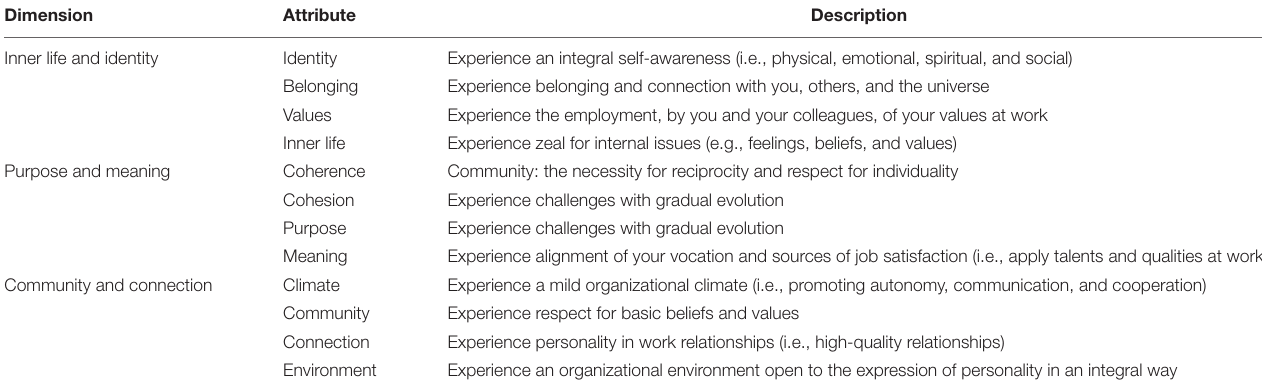
TABLE 1 | Workplace spiritual factors. Dimension Attribute Description Inner life and